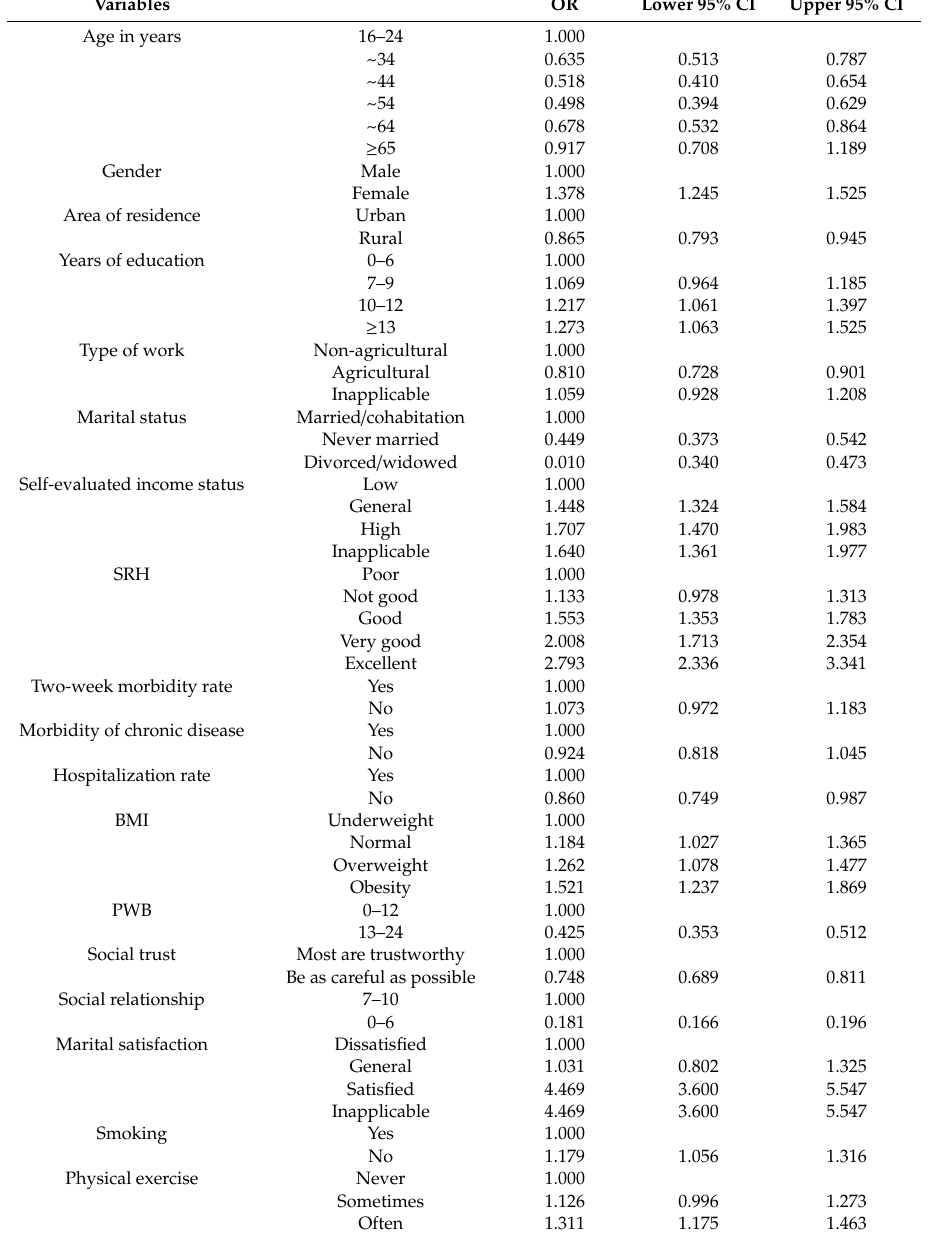
Table 3. Odds ratios with 95% confidence intervals of the association between SWB and various factors. Variables